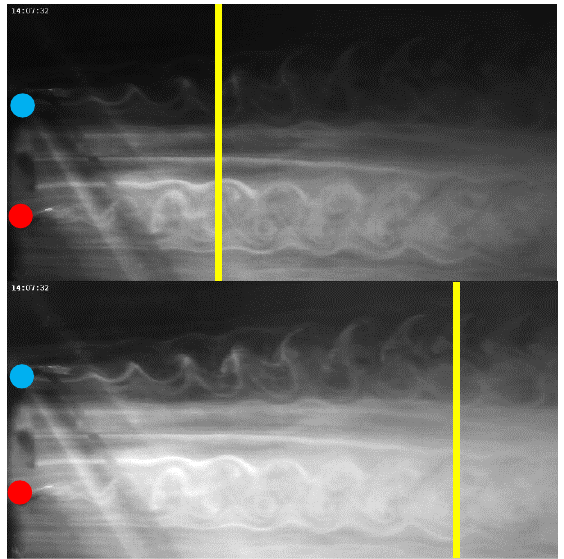
Fig. 5. Von Kármán vortex street for an isothermal case at two- time frames shifted by approximately 0.09 s. Upper blue point cooled cylinder (in this case, the cooling was switched off), lower red point reference cylinder.